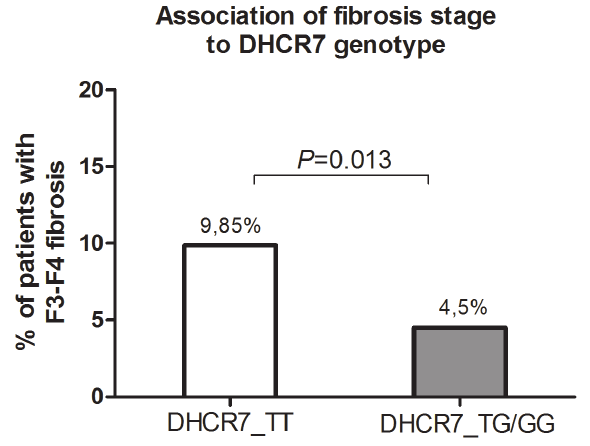
Figure 4. The DHCR7-TT- genotype of the rs12785878 SNP shows a significant association to stage of fibrosis.